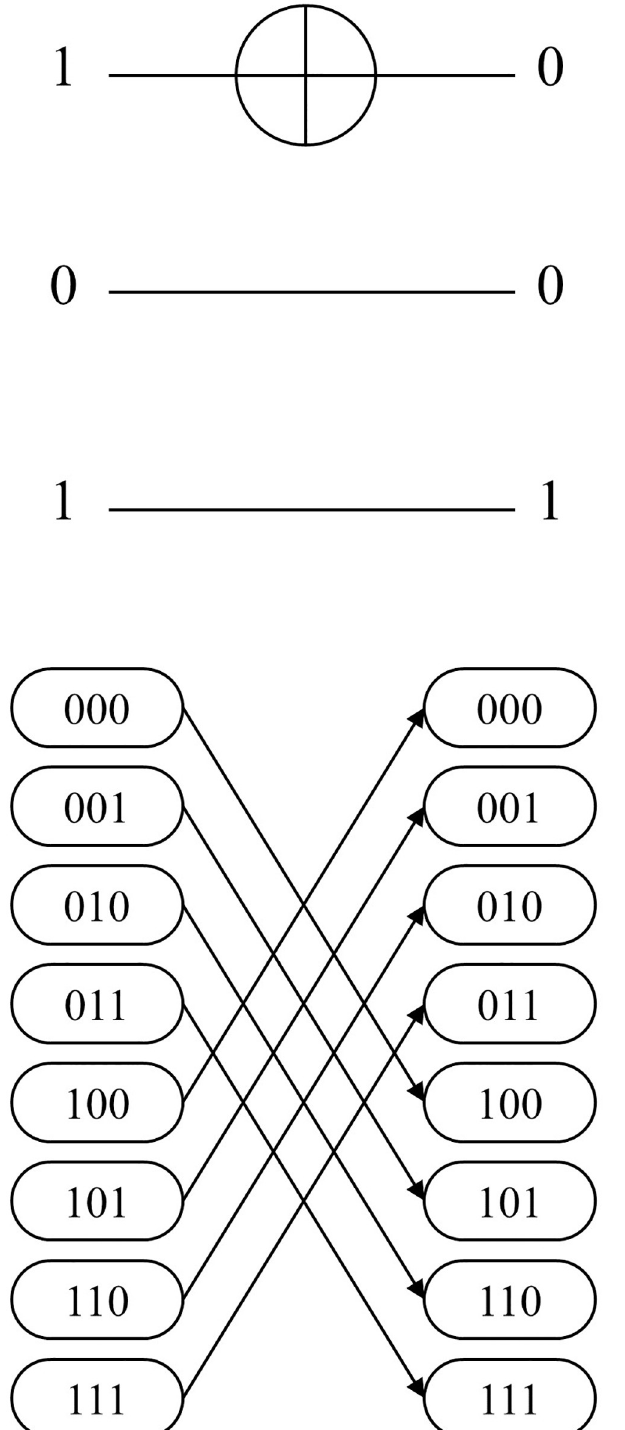
Fig 5. 3-qubit example of MCT gate-network conversion: CASE2 .